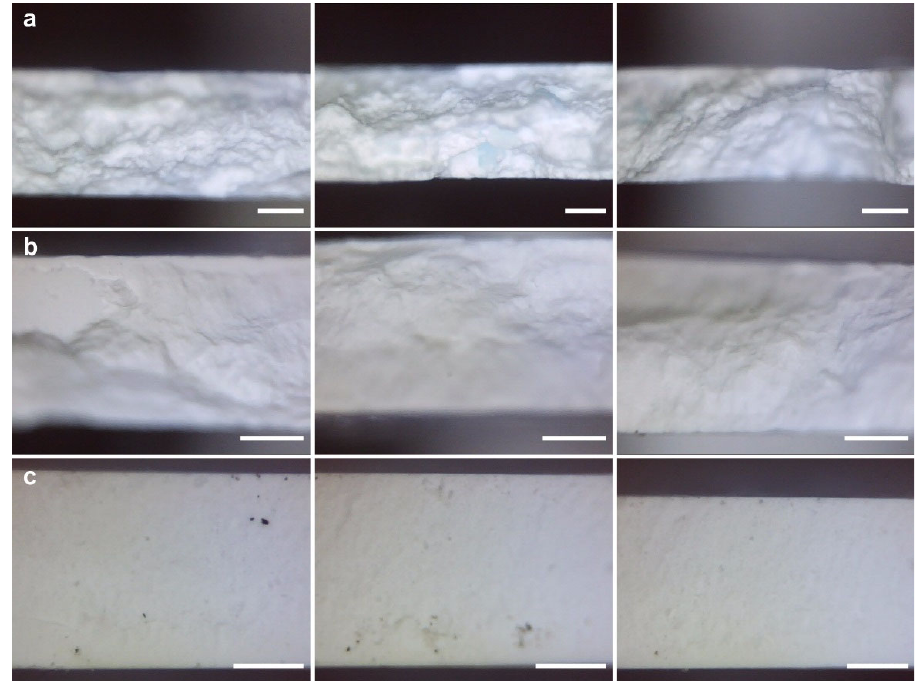
Figure 4. Optical micrographs of NASICON pellets ( a ) with pronounced clustering produced at low compacting pressure (cross ‐ section); ( b ) with smoother packing produced by high compacting pressure (cross ‐ section); and ( c ) riddled by random carbonic impurities introduced by improper handling and storage (peripheral surface). Scale bar at 500 μ m.